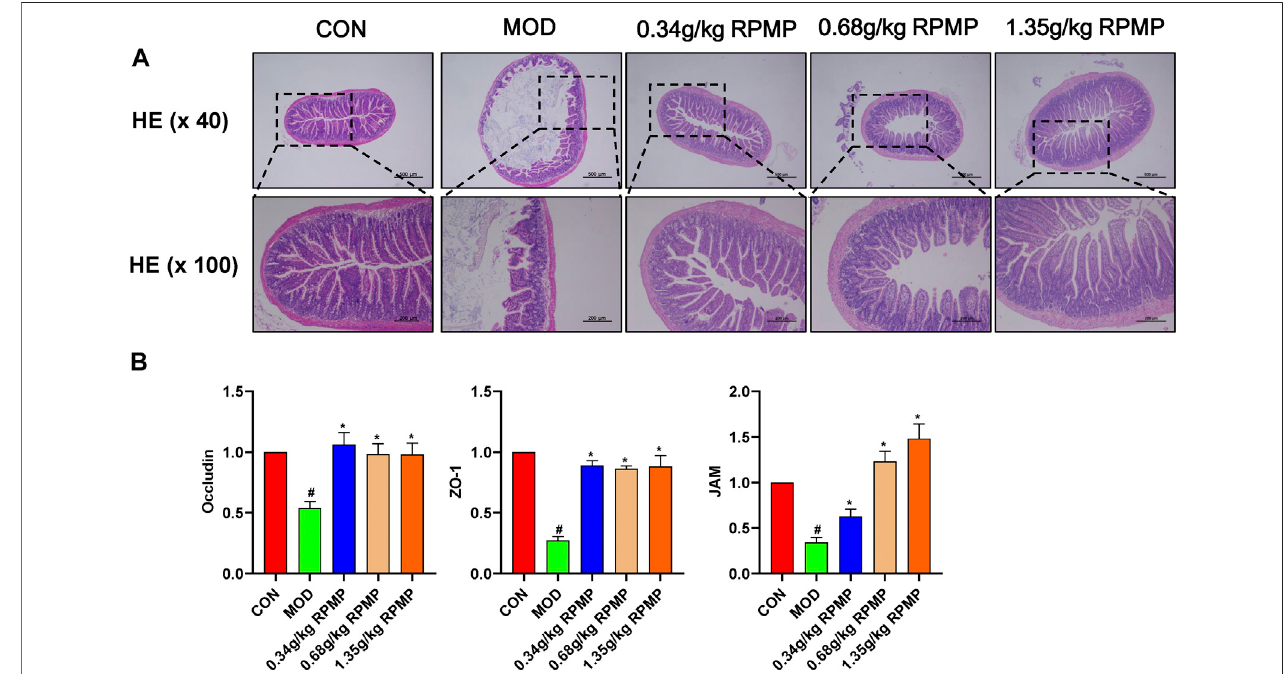
FIGURE9| Intestinalepithelialbarrier. (A) Colonicpathologyinmice( × 40and × 100). (B) EffectofRPMPethanolextractonintestinalbarrier-relatedgenes.Thedata were presented as the means ± SEM, # p < 0.05, compared with the ND group; * p < 0.05, compared with the HFD group ( n (cid:2) 6).